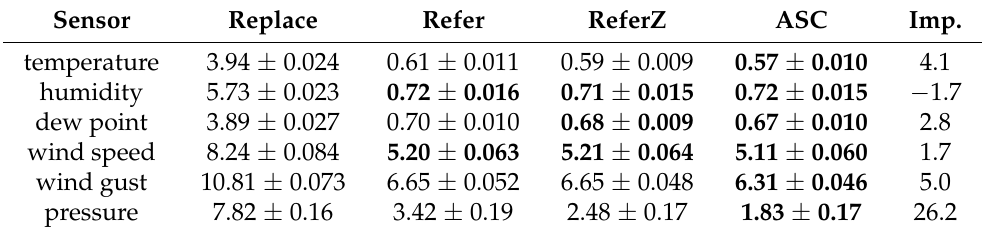
Table 1. Reconstruction errors (RMSE) on weather data for individual sensor changes. Each entry shows the average reconstruction error and the corresponding standard error. Imp. shows the average improvement (in %) of ASC over the best baseline method. The best performing method(s) (statistically significant up to one standard error) are in bold font.